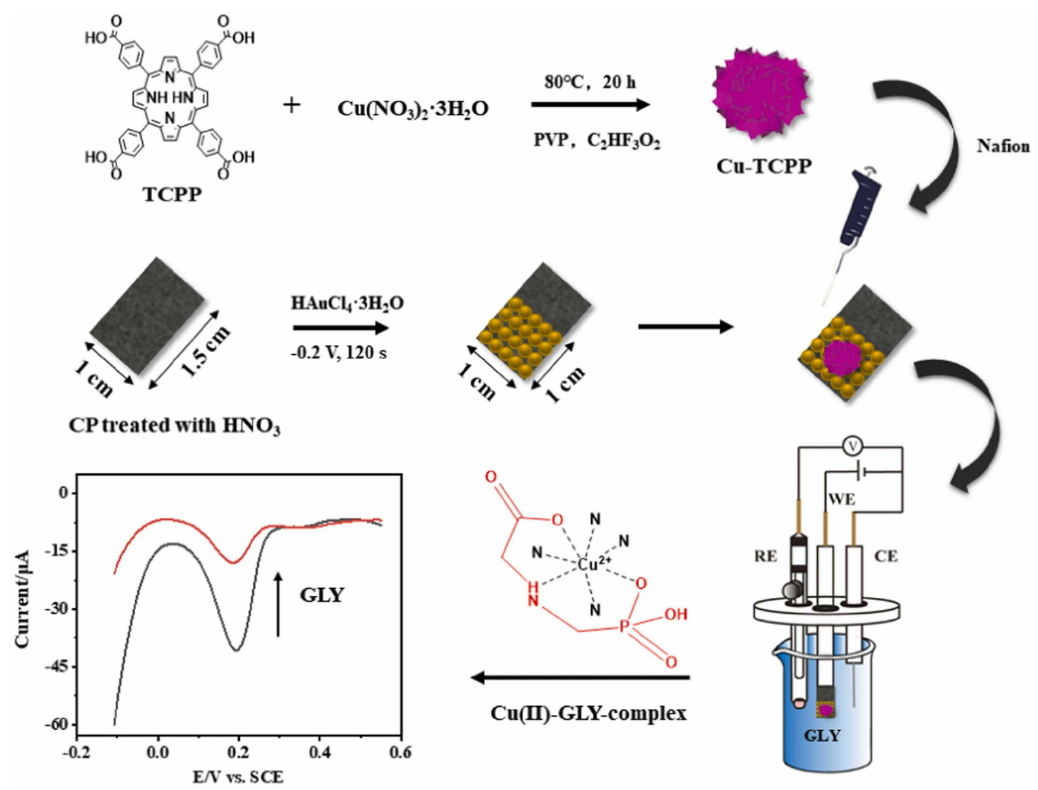
Figure 6. Scheme illustration of the fabrication of the Cu-TCPP/AuNPs/CP electrode and the electrochemical sensor for GLYP. Reprinted/adapted with permission from [115]. Copyright 2022 Elsevier.